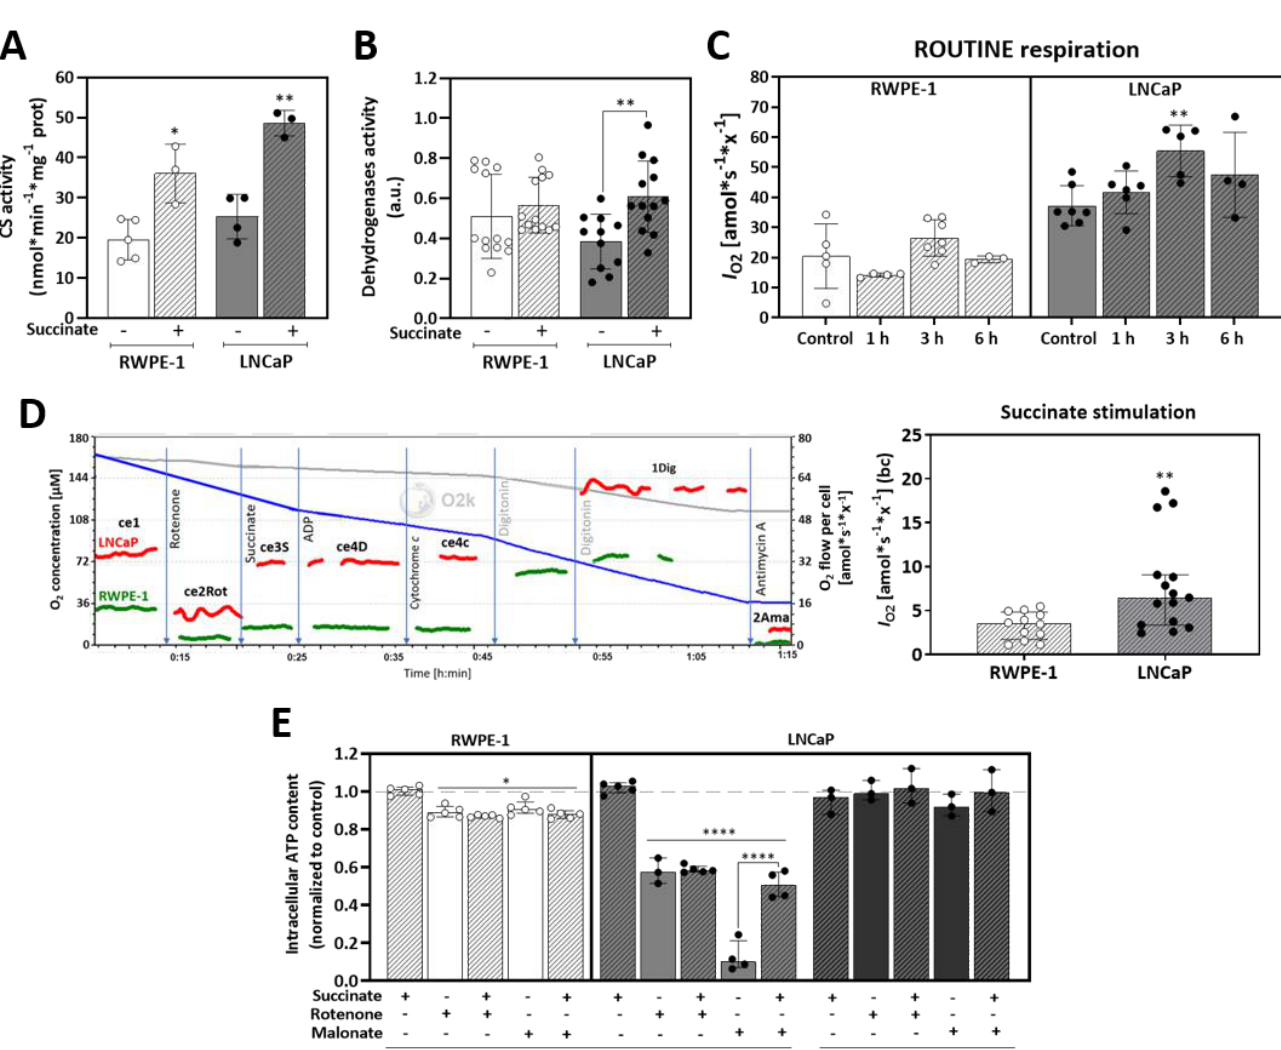
Figure 3. Succinate oxidation in mitochondria. ( A ) Citrate synthase activity (nmol * min − 1 * mg − 1 protein) with or without prior incubation with 5 mM succinate for 6 h ( N ≥ 3). ( B ) Dehydrogenases activity measured after incubation with 5 mM succinate for 6 h using a WST-1 assay ( N ≥ 11). ( C ) Time-course of ROUTINE respiration of living cells after incubation